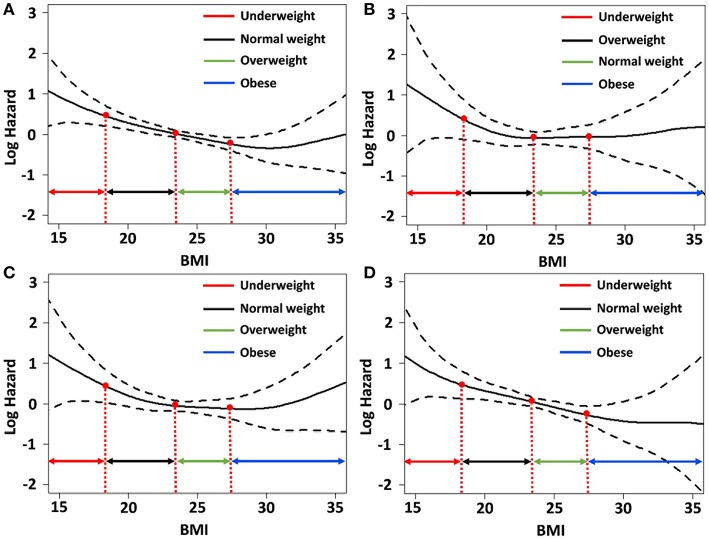
Relative hazards of body mass index (BMI) on (A) all-cause mortality; (B) fatal stroke; (C) fatal cardiovascular events; and (D) other-cause mortality after adjusting variables p < 0.1 in the univariate Cox regression analysis.